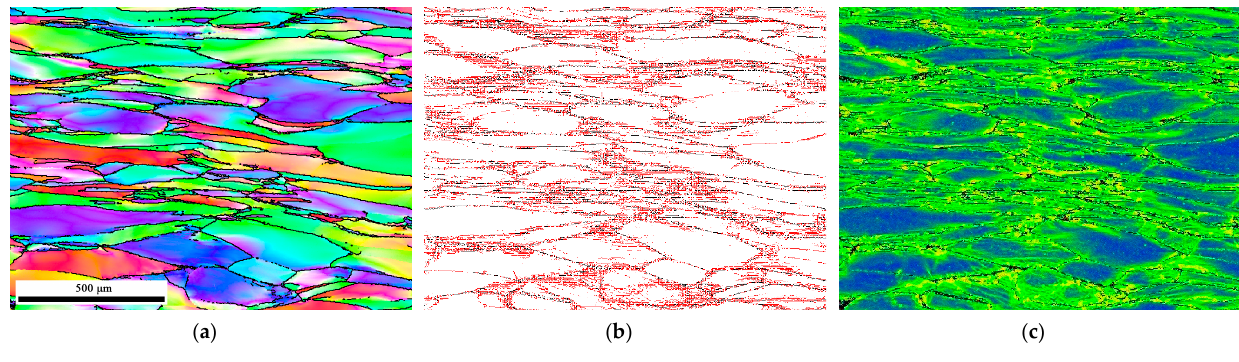
Figure 10. ( a ) IPF map, ( b ) GB map, and the ( c ) KAM map of low η